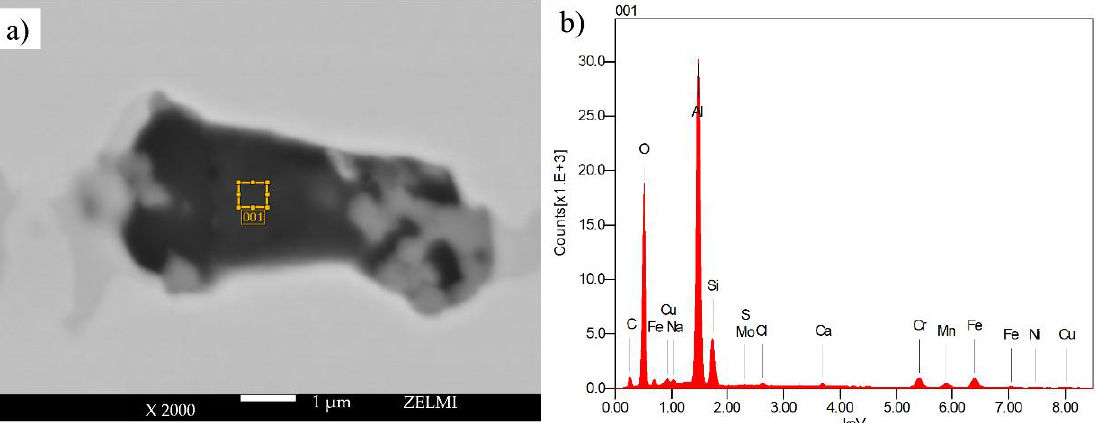
Figure 16. EDX measurement within a void in the sample sintered in ( a ) refractory ballast for 240 s and ( b ) the chemical composition of the refractory ballast sintered.